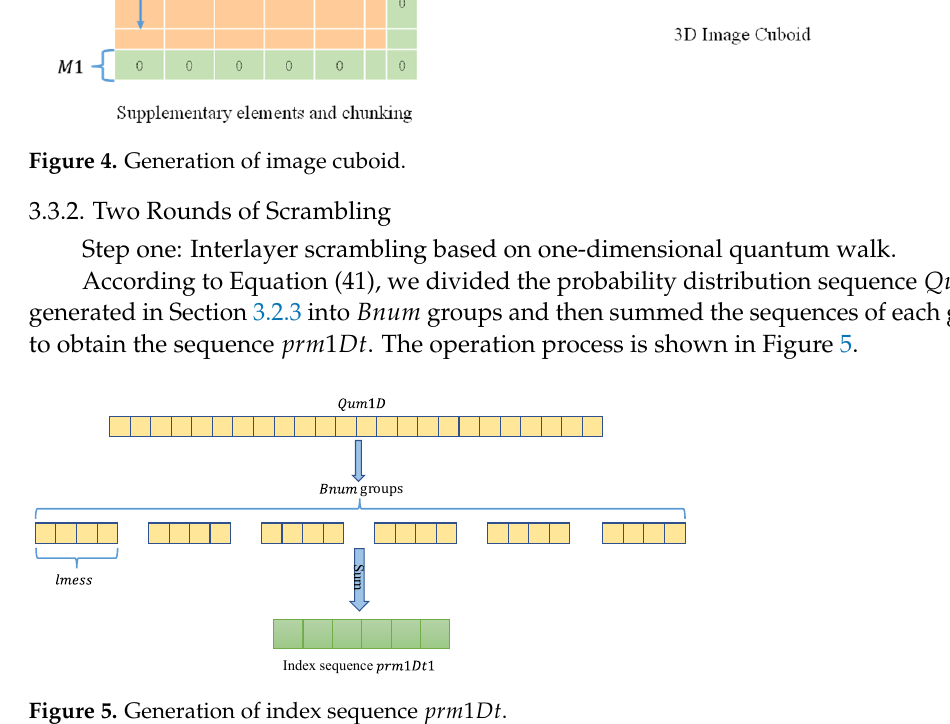
Figure 6. Interlayer scrambling of image cuboids.